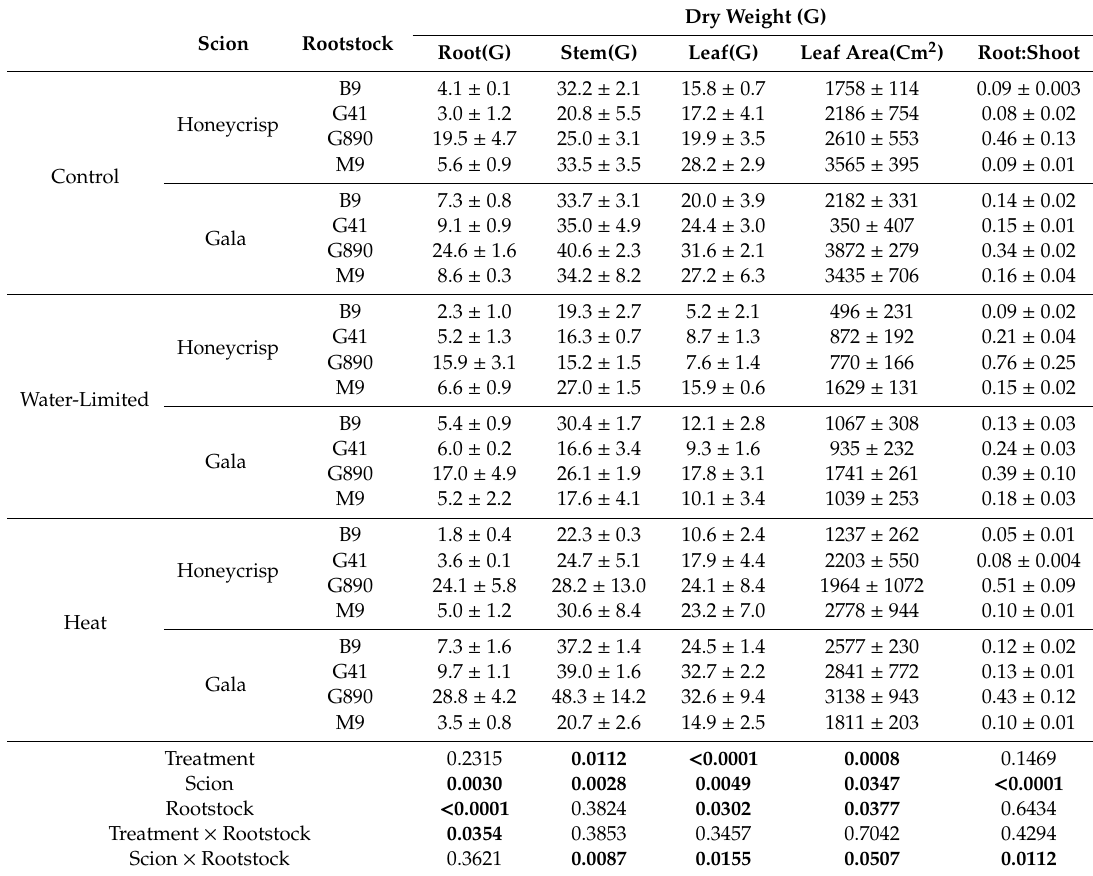
Table 1. Root, stem and leaf biomass (grams dry weight), total leaf area (cm 2 ) and root:shoot biomass ratio ( ± SE; n = 3) for ‘Gala’ and ‘Honeycrisp’ apple cultivars in combination with four rootstocks: B9, G41, G890, and M9 under water limitations or elevated soil temperatures compared to an untreated control. Values at the bottom correspond to the p -values of factors and its interactions that were significant for at least one variable; SE means standard